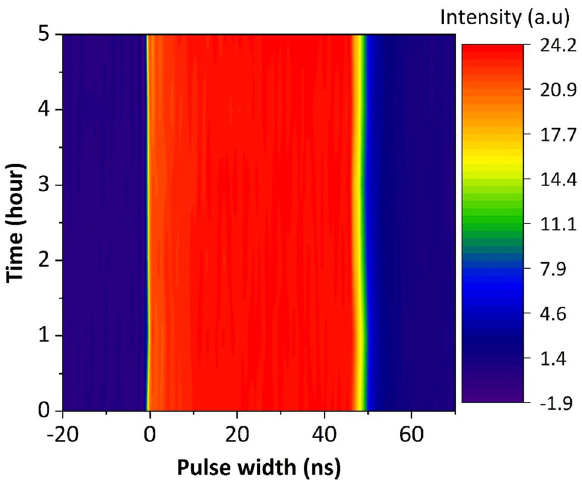
Figure 5. Stability measurement of the DSR operation made by repeateadly scanning the pulse profile during a ~ 5-h test.